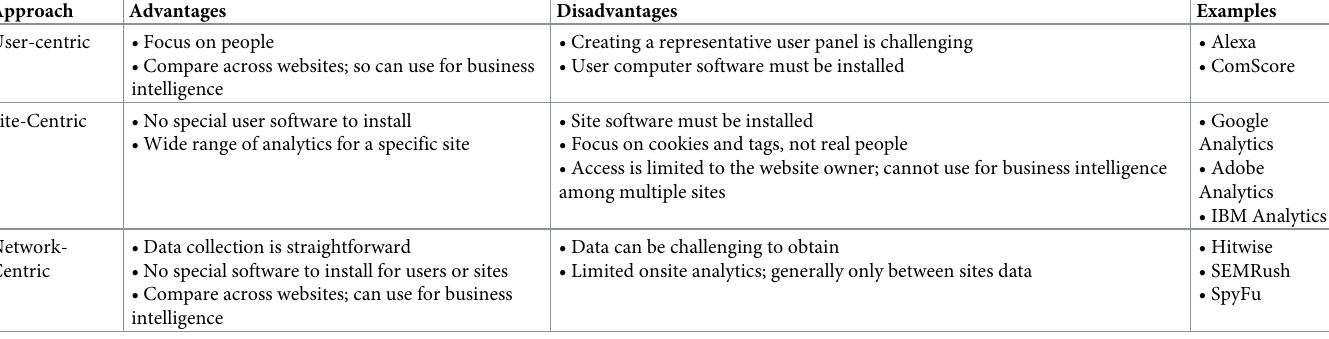
Table 1. Comparison of user, site, and network-centric approaches to web analytics data collection showing advantages, disadvantages, and examples of each approach at the time of the study.